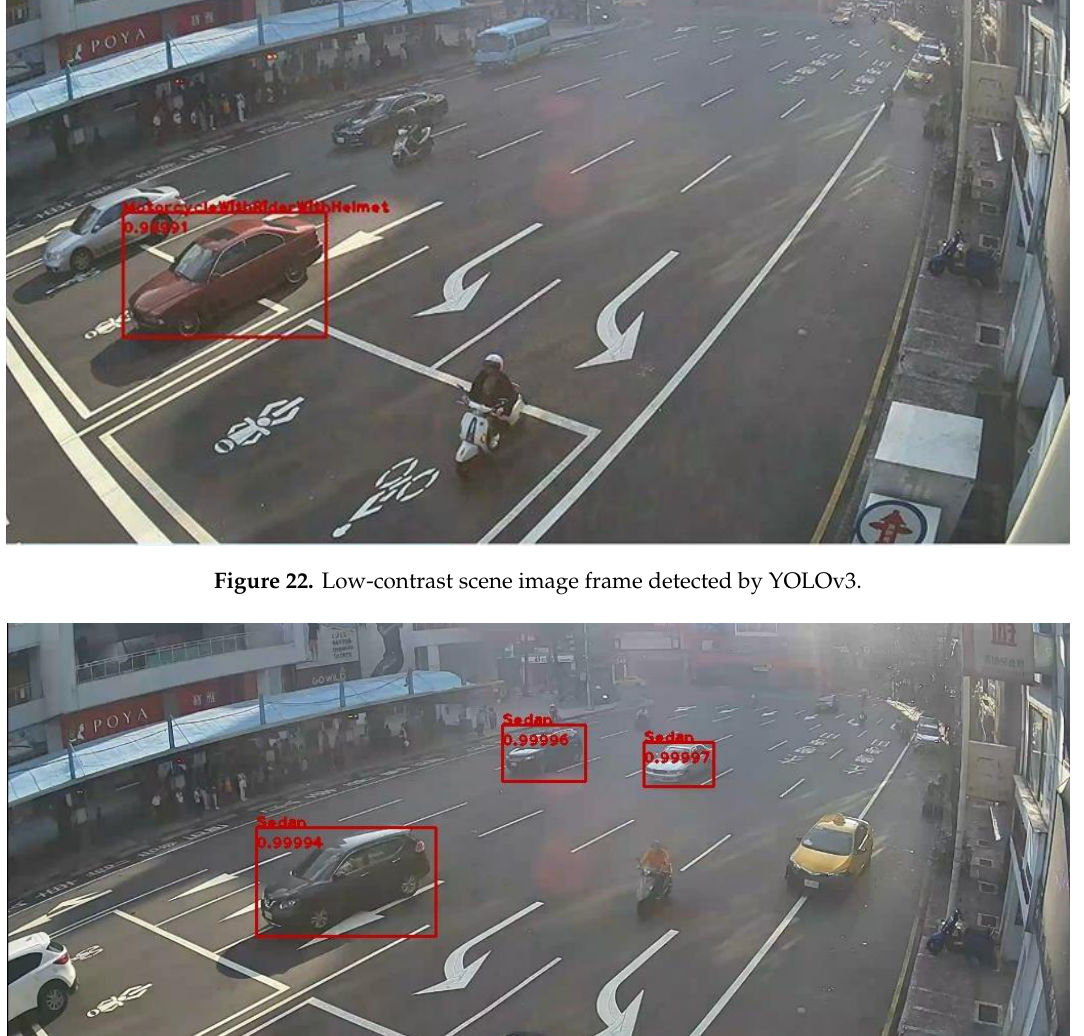
Figure 24. Low-contrast scene image frame detected by our proposed system.